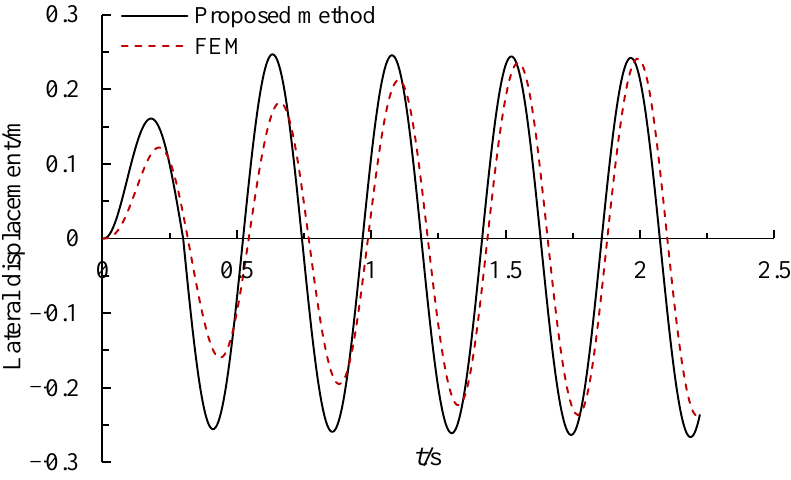
Figure 9. The time history response of lateral dynamic displacement atop the GBF ( f = 2.25 Hz). On the other hand, resonant frequencies and mode shapes are important properties for studying the dynamic characteristics of wind turbines. Therefore, the dynamic responses of the OWTs at different frequencies calculated by the present method are shown in Figure 10. The lateral load is a 100 kN sinusoidal load, whose magnitude is close to the combined wind and wave load. The lateral dynamic displacement is normalized by the displacement under static response. As shown in Figure 10, the resonant frequency of the OWTs is 0.26 Hz without considering the nonlinear interaction between the GBF and soil, which is almost equal to the 0.283 Hz obtained by the finite element method [24]. This comparison also ensures the reliability of the present simplified method for elastic analysis. The resonant frequency of the OWTs is about 0.25 Hz when considering the nonlinear interaction between the GBF and soil. Obviously, the effect of soil nonlinearity will result in an increase in the amplitude of the dynamic response of the OWTs and a decrease in the resonant frequency of the